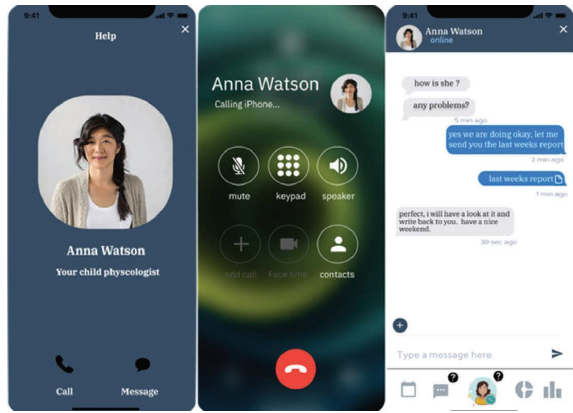
Figure 8: Current design and added features.